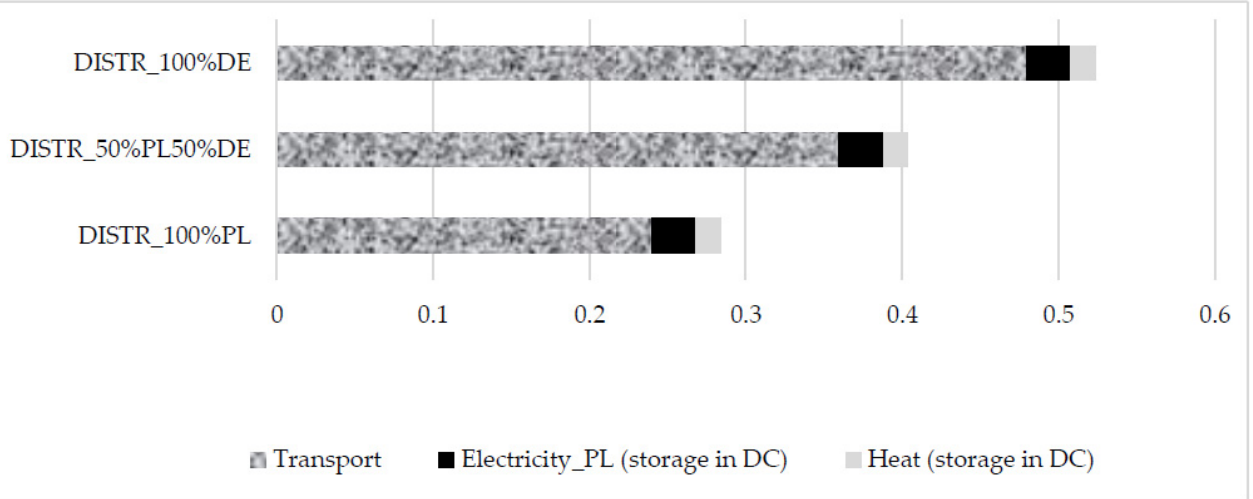
Figure 3. Environmental impact of the life cycle stage Distribution (DISTR) per 1 refrigerator (0.523 Pt = 100%DE, 0.404 Pt = 50%PL50%DE, 0.284 Pt = 100% PL, decrease by 46%).